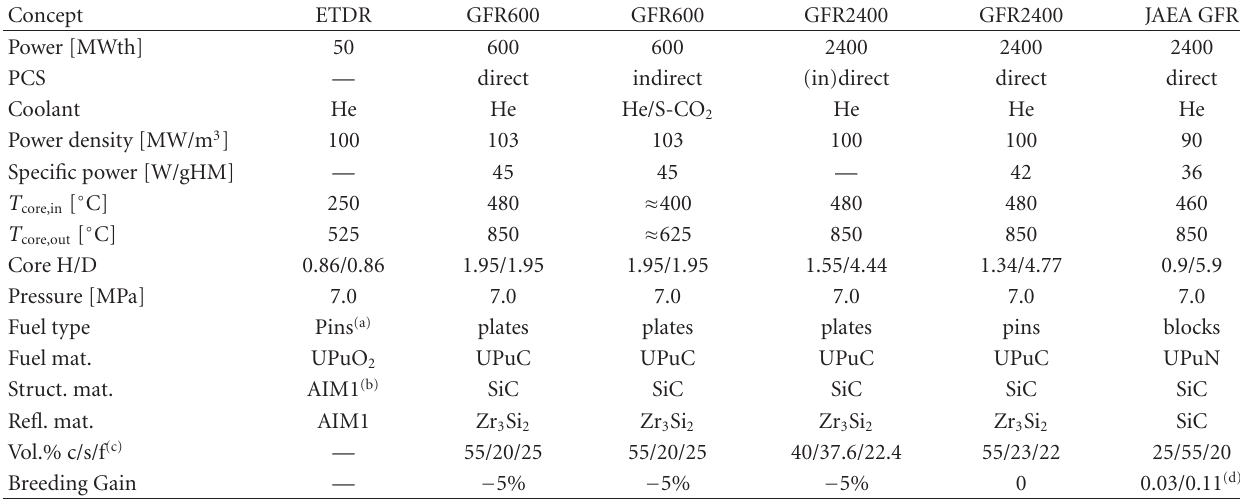
Table 2: Design data for several Generation IV GFRs, per July 2006. For all Direct Cycle reactors, helium is the preferred coolant. For the GFR600 Indirect Cycle variant, supercritical CO 2 (S-CO 2 ) is the secondary coolant. Note that the 600 MWth are currently no longer investigated. For the 2400 MWth Indirect Cycle concept, various secondary cycles and working fluids are under consideration. The JAEA GFR has blankets to breed just enough new fissile material to allow operation in a closed fuel